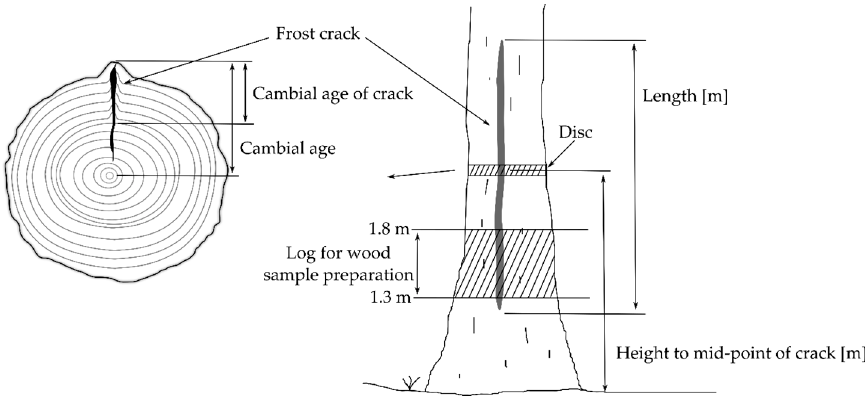
Figure 1. The method of frost crack measurement.